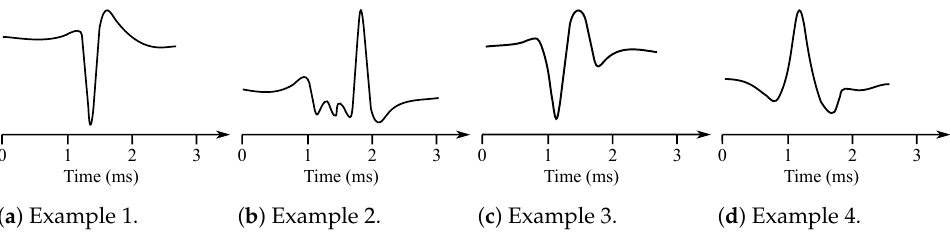
Figure 2. Examples of the MUAP potentials.